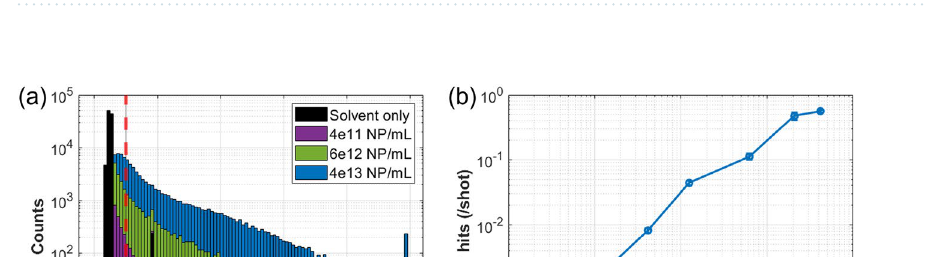
Table 2. Detailed NP information for the samples used. The concentration presented is the commercially available concentration, some samples were further diluted and are noted as such in the text.